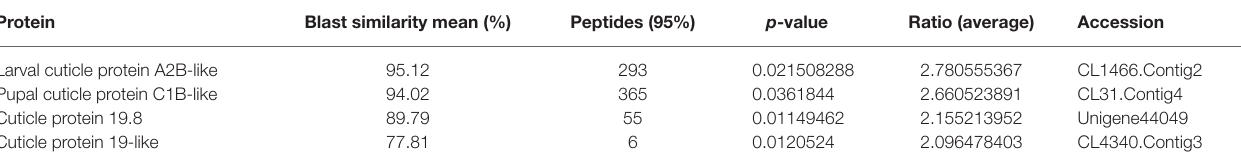
TABLE 1 | Cuticle proteins and homologies in 20E-treated A. lucorum . Protein Blast similarity mean (%) Peptides (95%) Larval cuticle protein A2B-like